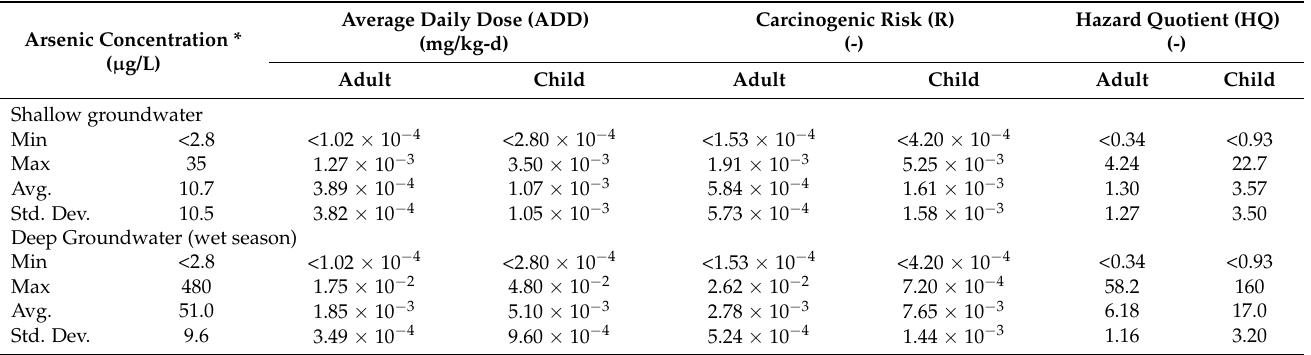
Table 4. Human risk assessment for consumption of arsenic-contaminated groundwater in the western part of the Lampang